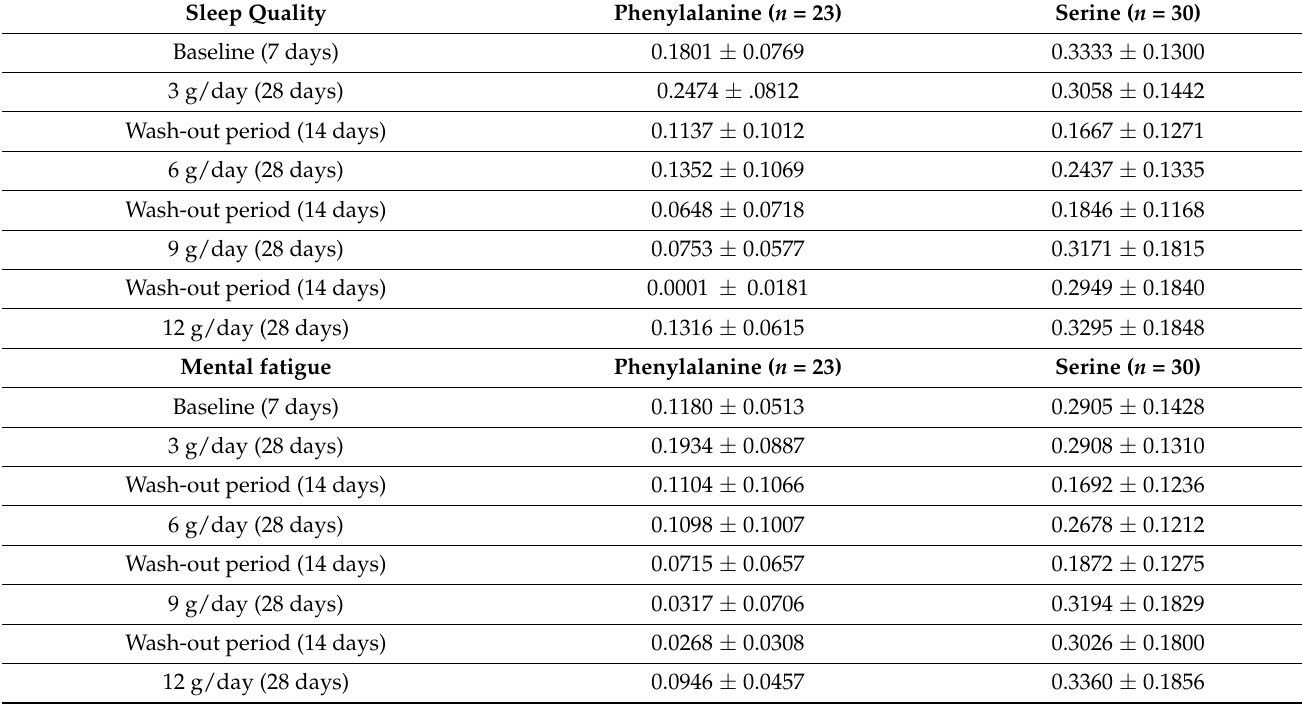
Values represent mean ± SEM of all tested subjects (n) over the whole period of supplementation (28 days), baseline (7 days) and wash-out recovery periods (14 days). One-way ANOVA was followed with Tukey’s multiple comparisons test between each amino acid intake, baseline and wash-out